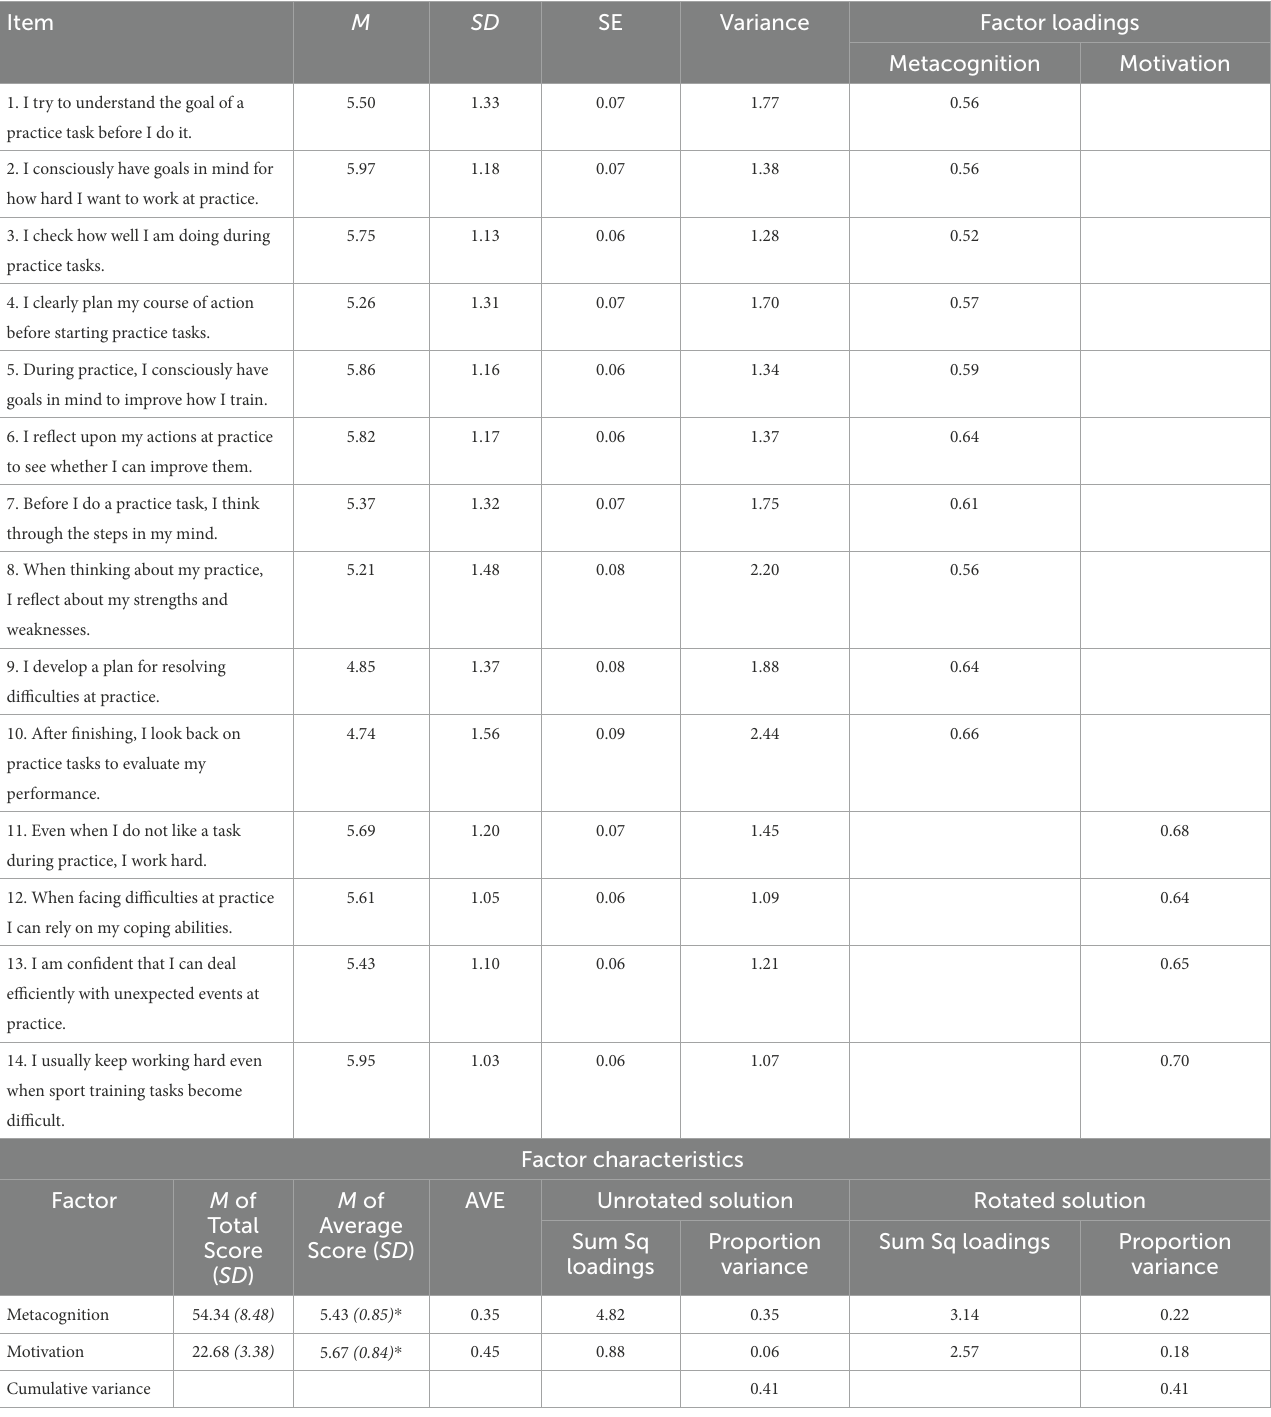
TABLE 1 Mean, standard deviations, standard error, variance, and factor loadings based on the confirmatory factor analysis. Item M SD